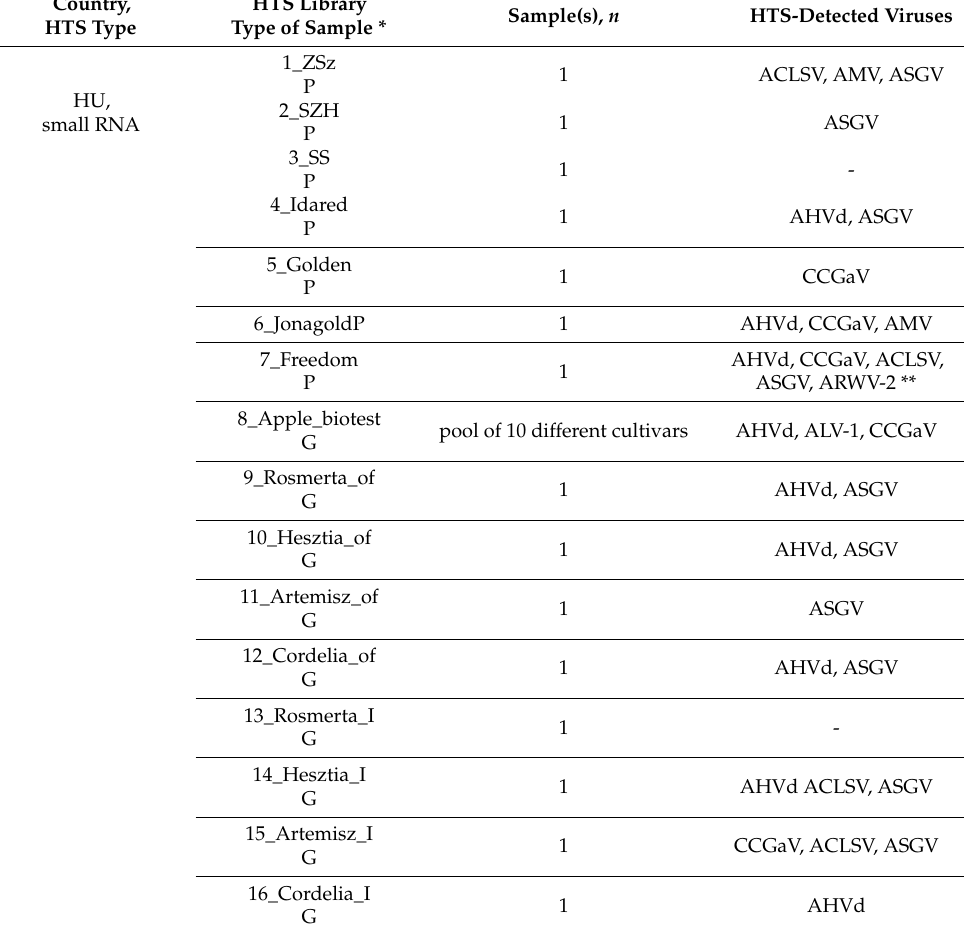
Table A1. Cont. Country, HTS Type